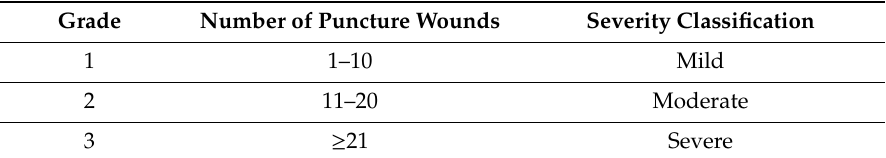
Table 2. Wound assessment